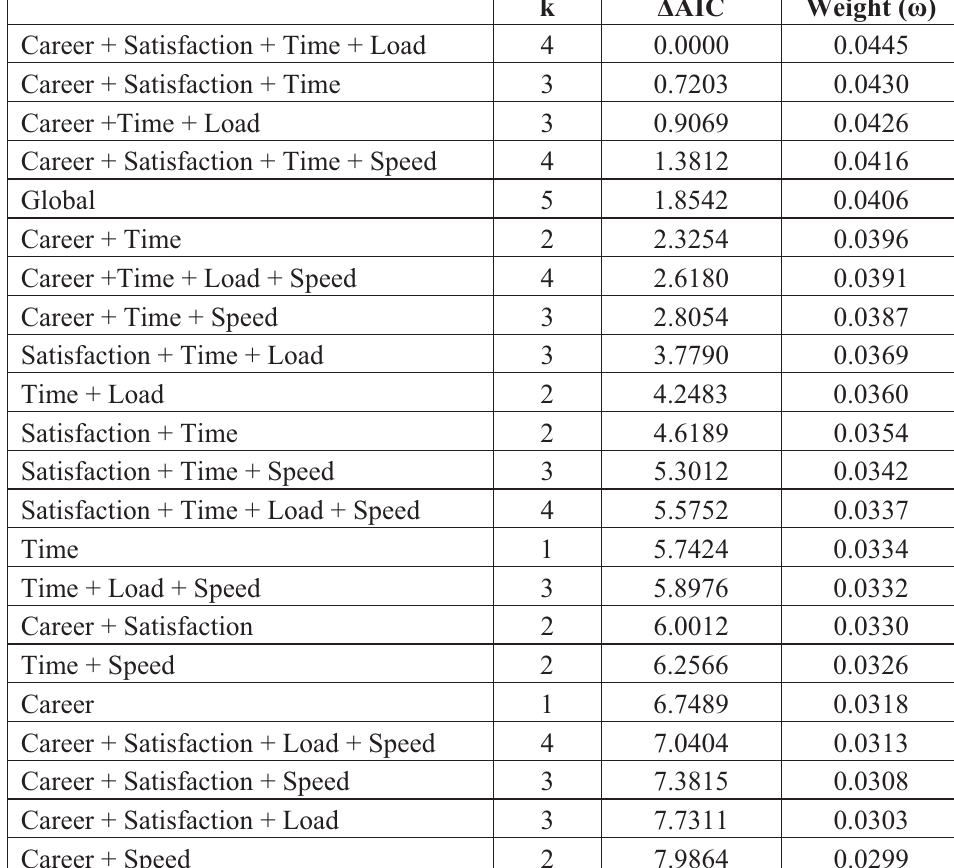
Table 3. Total hand pain results (k = number of